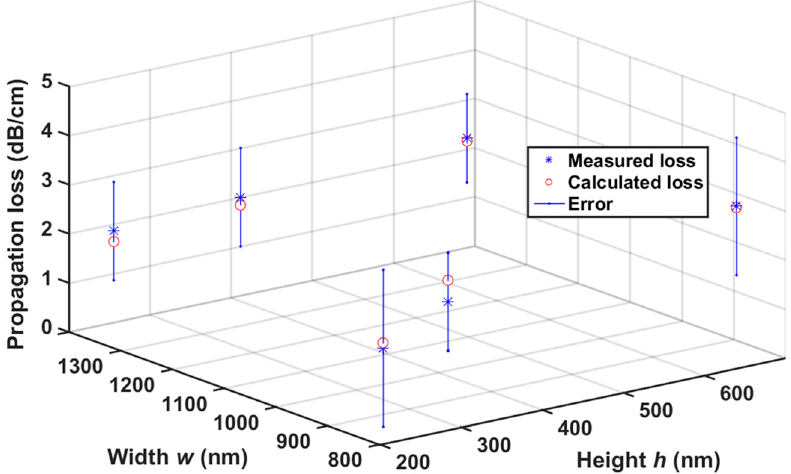
Figure 3. The measured and calculated propagation losses of the fabricated silicon-rich nitride ridge waveguides with di ff erent